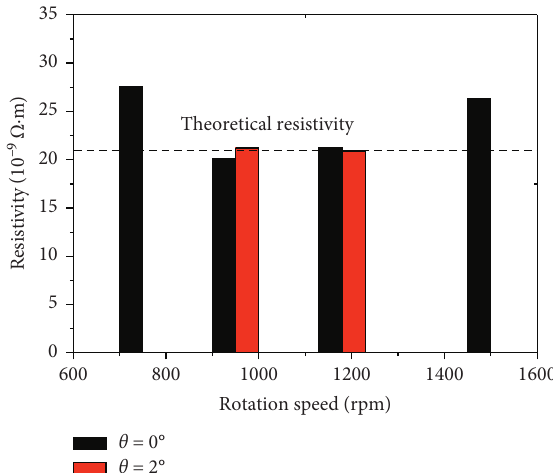
Figure 11: The resistivity of the Al-Cu FSW joint produced by different